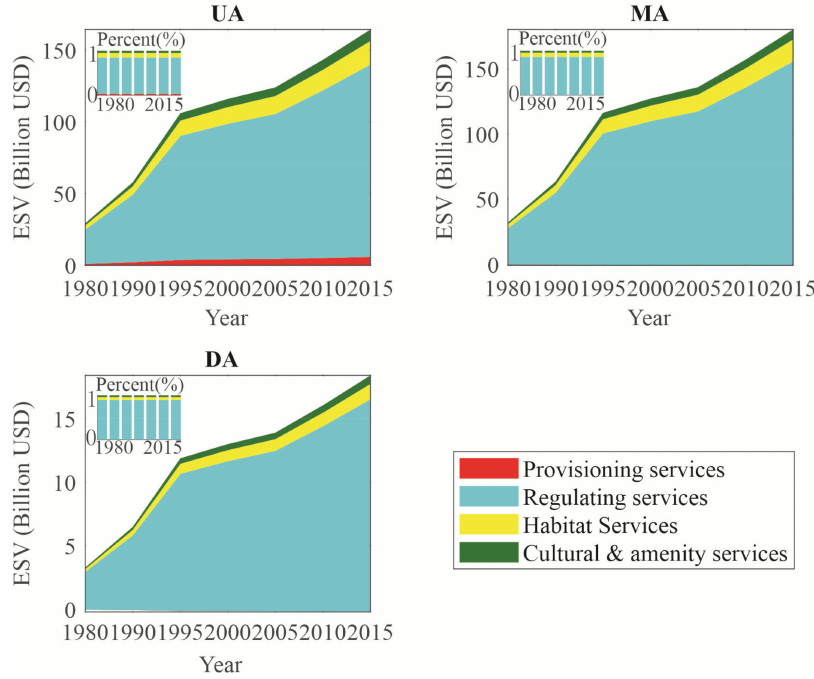
Figure A2. ESV of YRB, SA, UA, MA, and DA from 1980 to 2015 considering changing standard equivalence coefficients. The annual Consumer Price Index (CPI) was used to revise the standard equivalence coefficients for different periods, the revised standard equivalent coefficient values for the years 1980, 1990, 1995, 2000, 2005, 2010, and 2015 are 102.78, 203.12, 372.54, 407.37, 435.52, 503.2, and 577.45 USD ha − 1 , respectively. The sub-figure describes the proportion of each ES